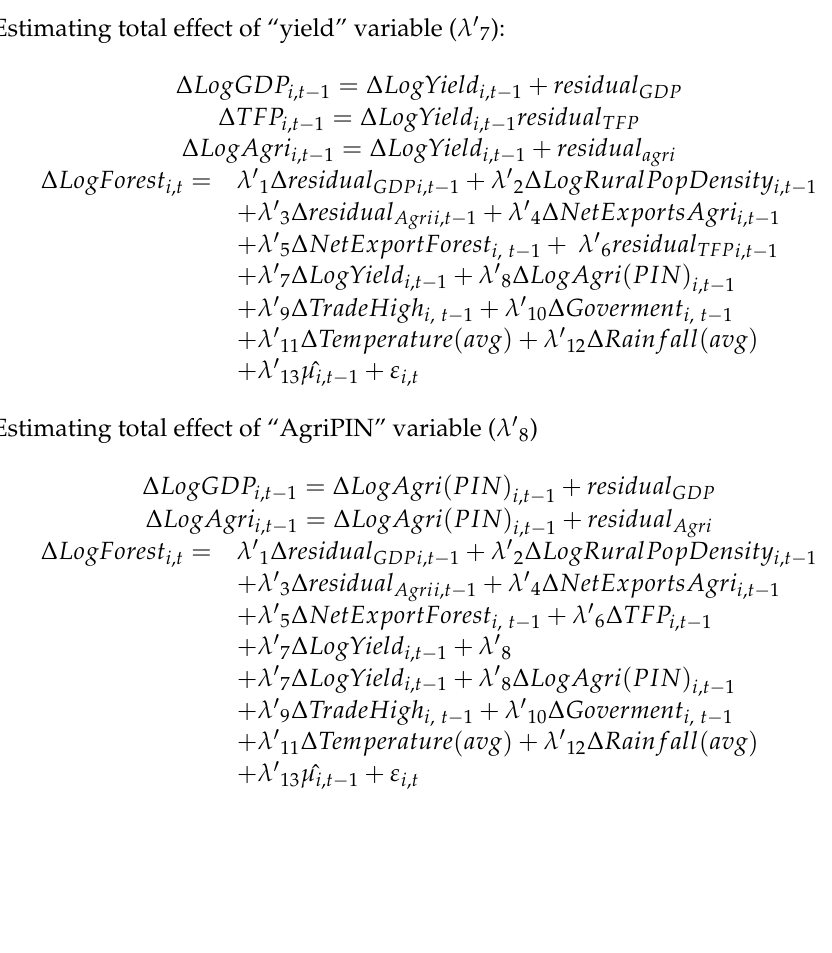
Figure A7. Estimating indirect effects of “Agricultural TFP”